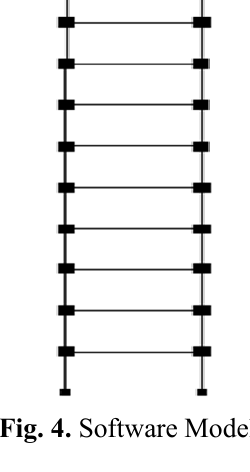
Fig. 4. Software Model.